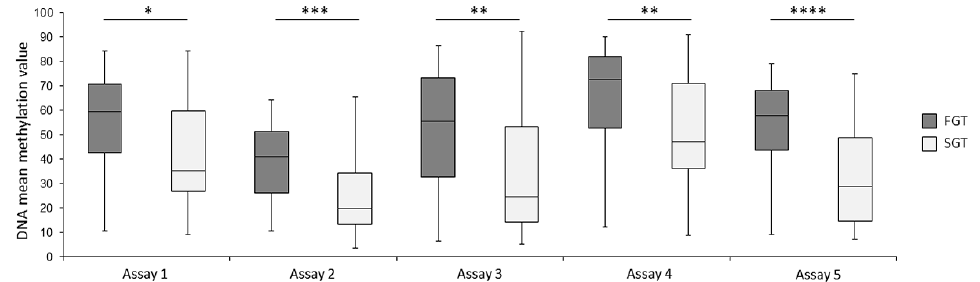
Figure 4. Mean methylation differences between fast-growing (dark gray) and slow-growing (light gray) tumors for each assay performed by DNA bisulfite pyrosequencing. * p < 0.05, ** p < 0.001, *** p < 0.0001, **** p < 0.00001.